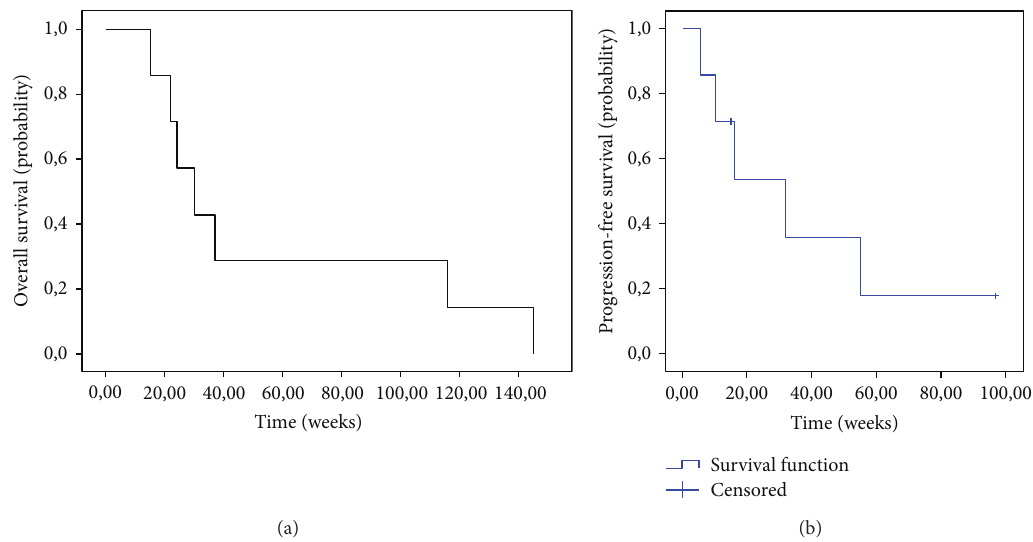
Figure 1: Kaplan-Meier curves of (a) overall survival and (b) median progression-free survival.